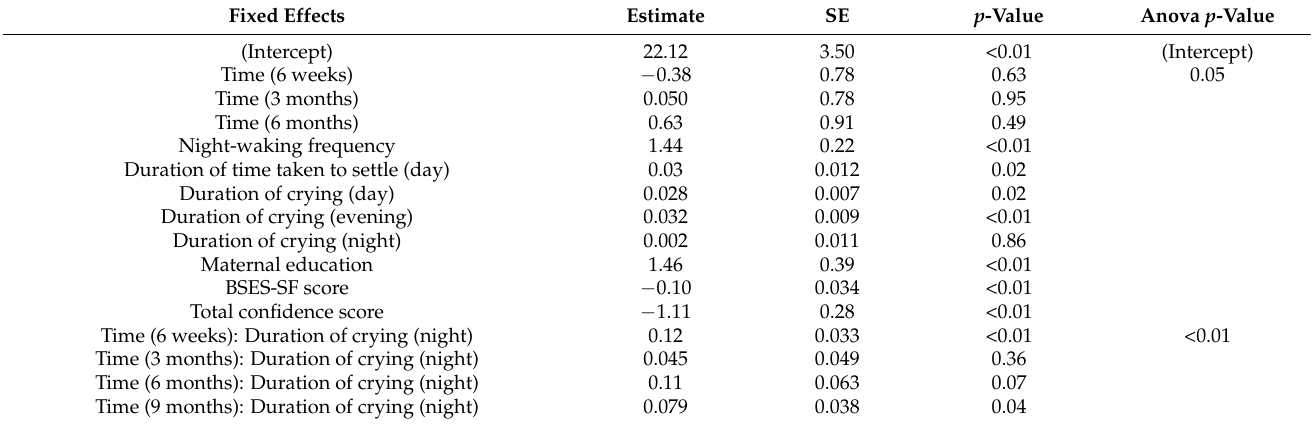
Table 4. Linear mixed models using feed, sleep, settle and cry variables to predict total bother scores.